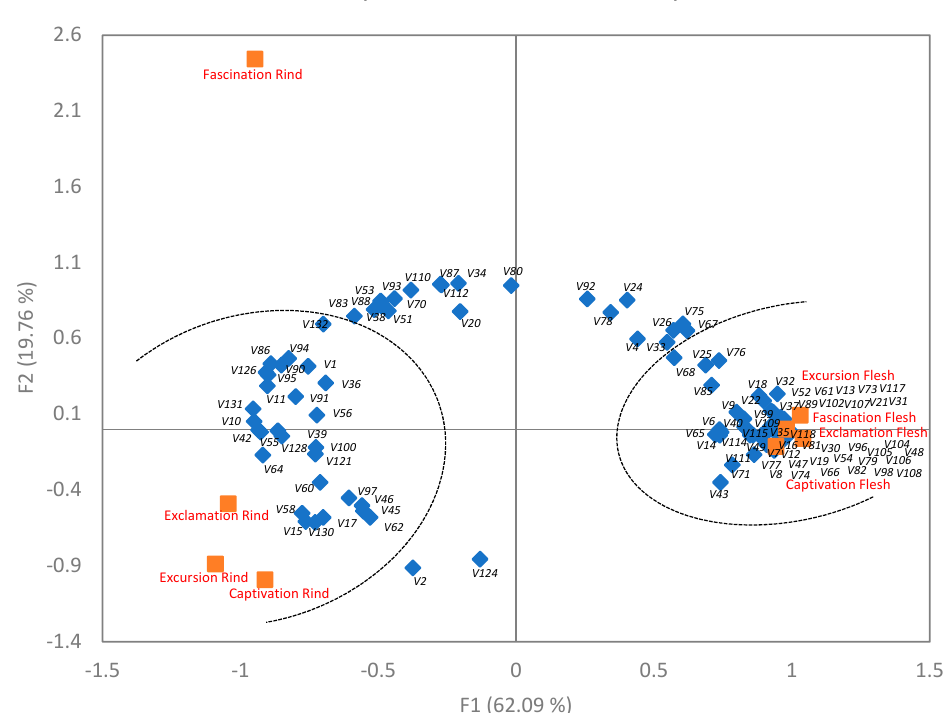
Figure 2. Principal component analysis (PCA) biplot using eight watermelon samples as score values and 106 selected volatiles (% peak area, cos 2 > 0.5) as loading values. Rectangle markers indicate watermelon rind and flesh samples, and diamond markers indicate volatiles. According to XLSTAT PCA output of “squared cosines of the variables” and “squared cosines of the observations”, two oval circles with dot lines were created on the basis of variables (volatiles) and observations (samples), which were significantly separated from other samples at either the positive or the negative side of PC1. Volatile compound names for V1–V132 could be found in Table 1. V = volatiles.